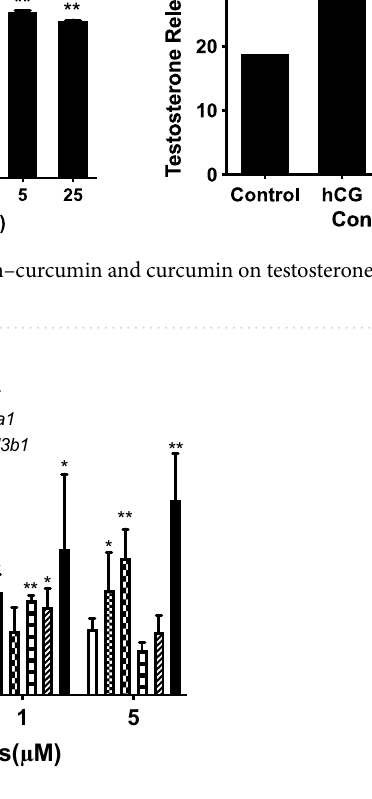
Figure 3. Effects of β-cyclodextrin–curcumin on the mRNA expression levels of Nr5a1 and steroidogenic enzymes in Leydig cells. * P < 0.05, ** P < 0.01 respect to